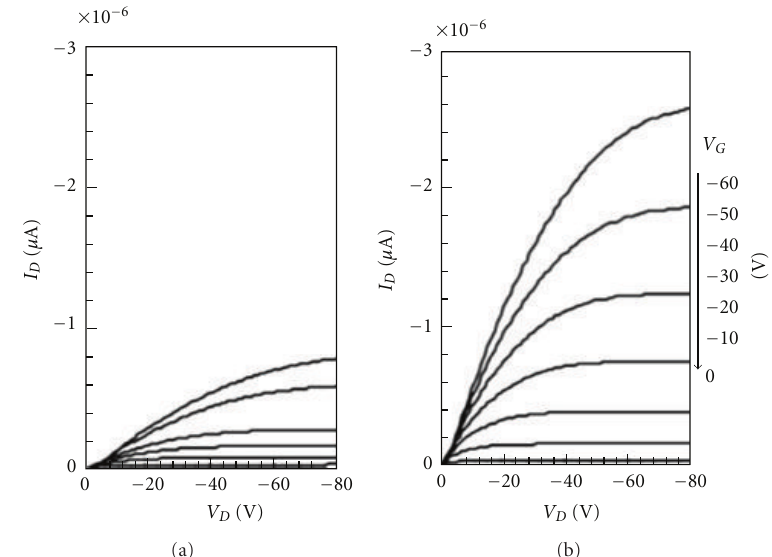
Figure 10: Output characteristics of P3HT TFTs fabricated on (a) non-treated PMSQ film and (b) OTS-treated PMSQ film, at gate voltages V G = 0, − 10, − 20, − 30, − 40, − 50, and −